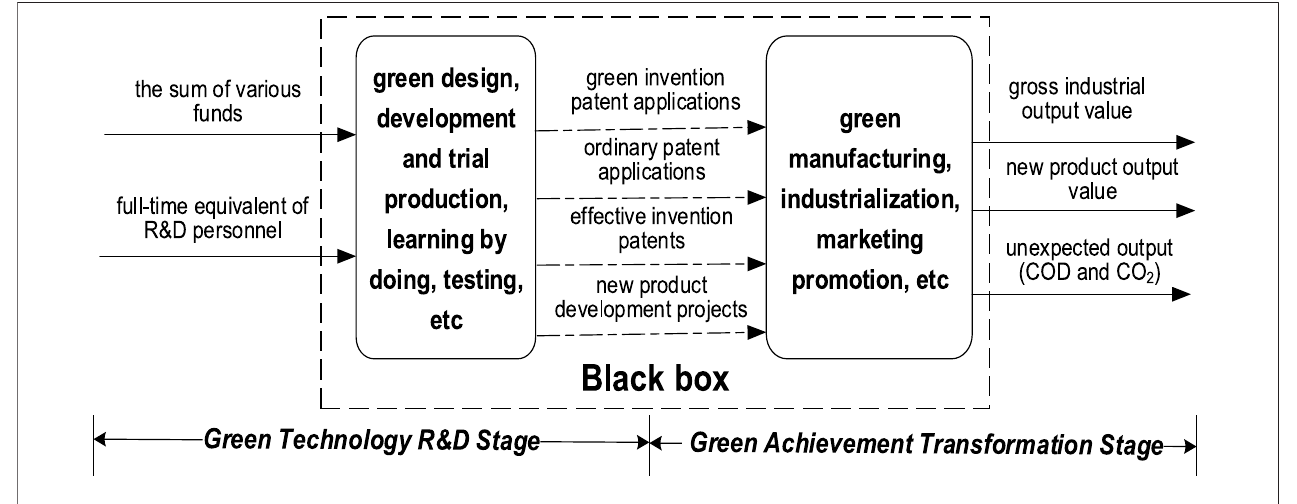
FIGURE 2 | Input – output diagram of two-stage